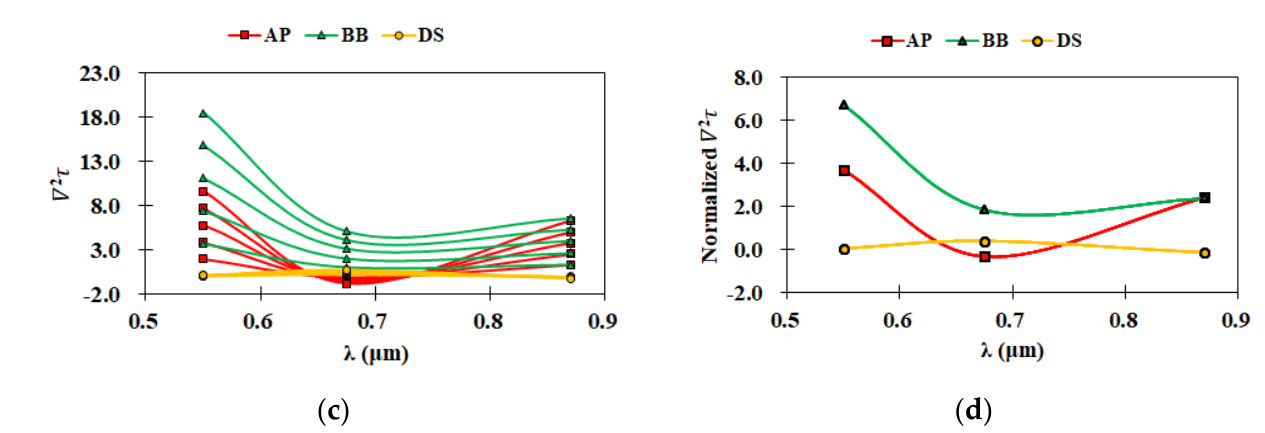
Figure 3. The first and second–order derivatives of spectral AOD before (panel a , b ) and after (panel c , d ) optical depth normalization along with the wavelength for DS (yellow), BB (green) and AP (red) aerosols. Each curve is fitted using the Bezier curve method.